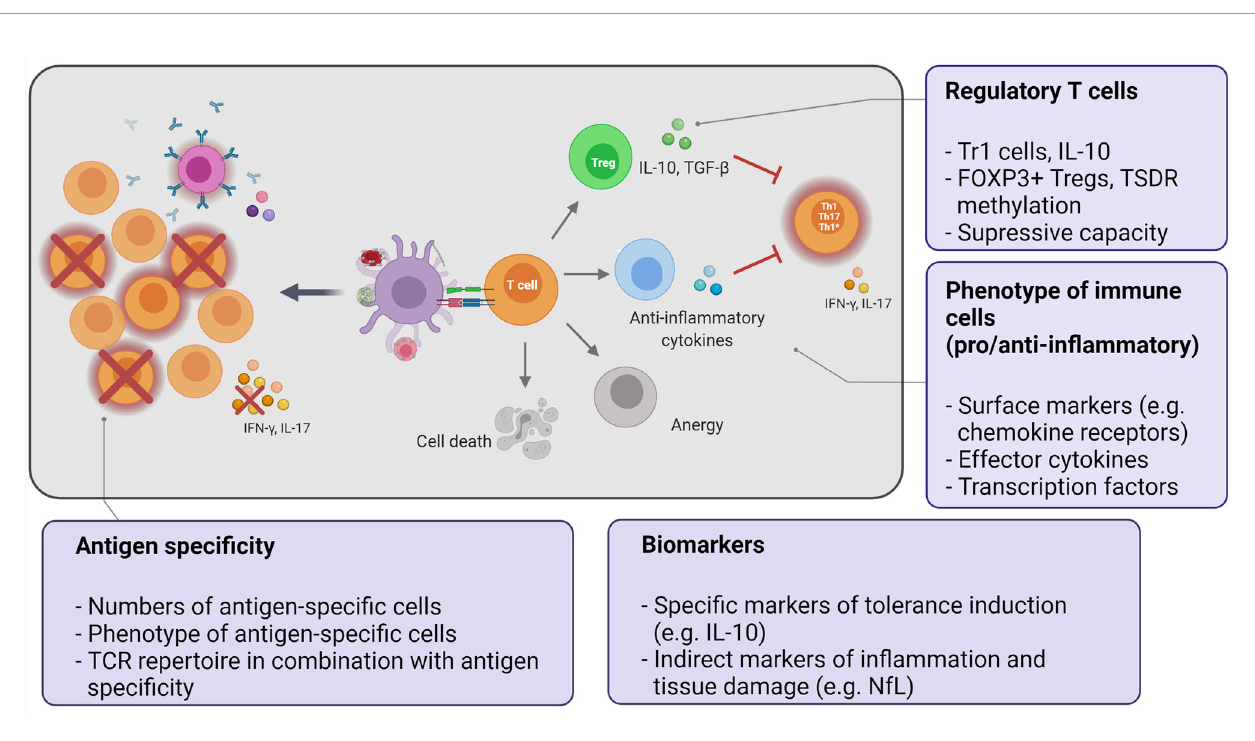
FIGURE 1 | Key aspects of the mechanistic program to monitor immune tolerance. Tolerization strategies employ different approaches to deliver the autoantigen to tolerogenic antigen-presenting cells in order to induce or enhance peripheral tolerance mechanisms. The potential mechanisms of tolerance induction can directly delete or silence autoreactive cells or indirectly suppress them by induction of regulatory T cells or effector T cells producing immunomodulatory cytokines (immune deviation). The fi nal outcome is the reduction of autoreactive, pathogenic effector cells (Th1/Th17/Th1*). Text bubbles summarize the key aspects of the mechanistic